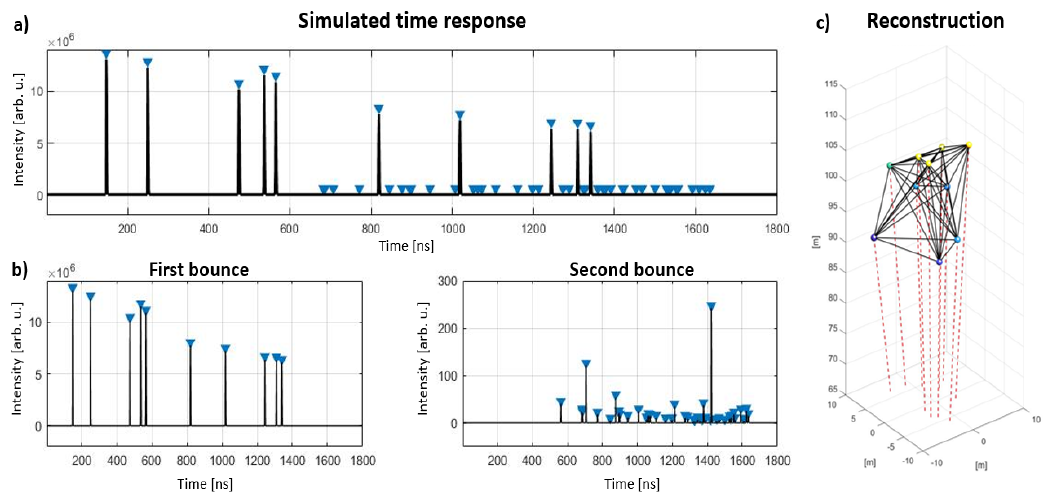
Figure 3. Time response and reconstruction ( a ) Total time response of a scene with 10 randomly generated points. The time response includes the first and second bounces. The peak extraction algorithm is applied to find peaks. The peaks are marked by blue triangles. ( b ) Second bounce time response; ( c ) Reconstruction of the point-cloud. After applying a peak extraction algorithm, modified TRIBOND is used to reconstruct the point-cloud. The red dotted line corresponds to the first bounce path connecting point in the scene and imaging system. The black line is the second bounce